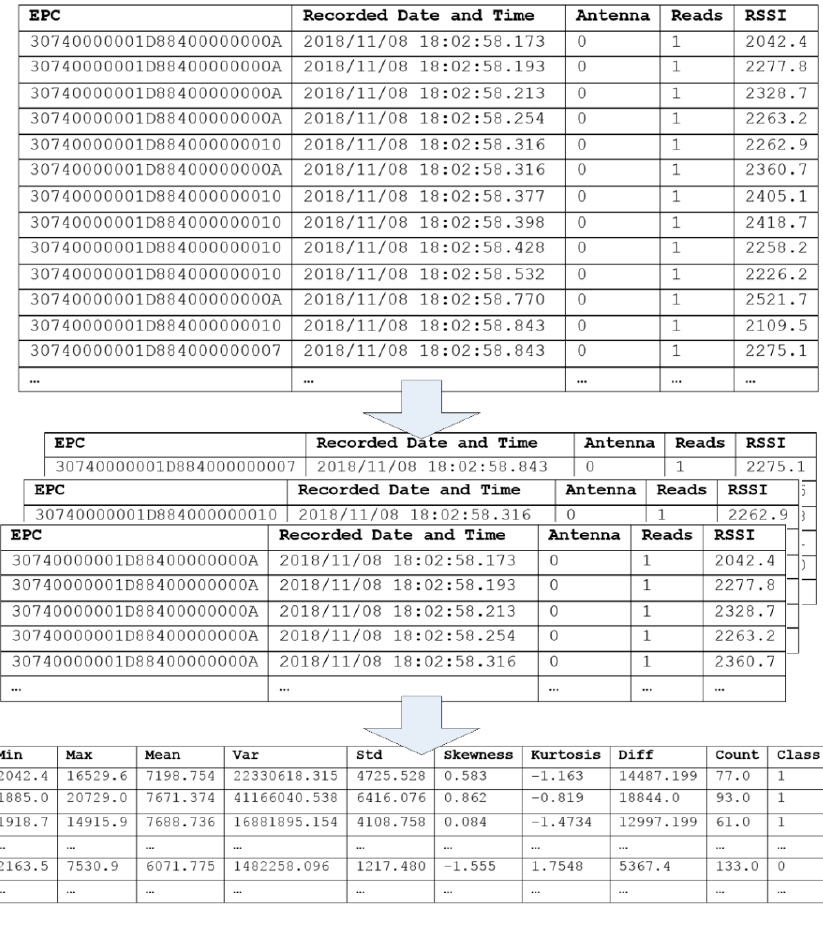
Figure 4. Example of raw RFID data transformation. Table 3. Prediction accuracy using individual features.